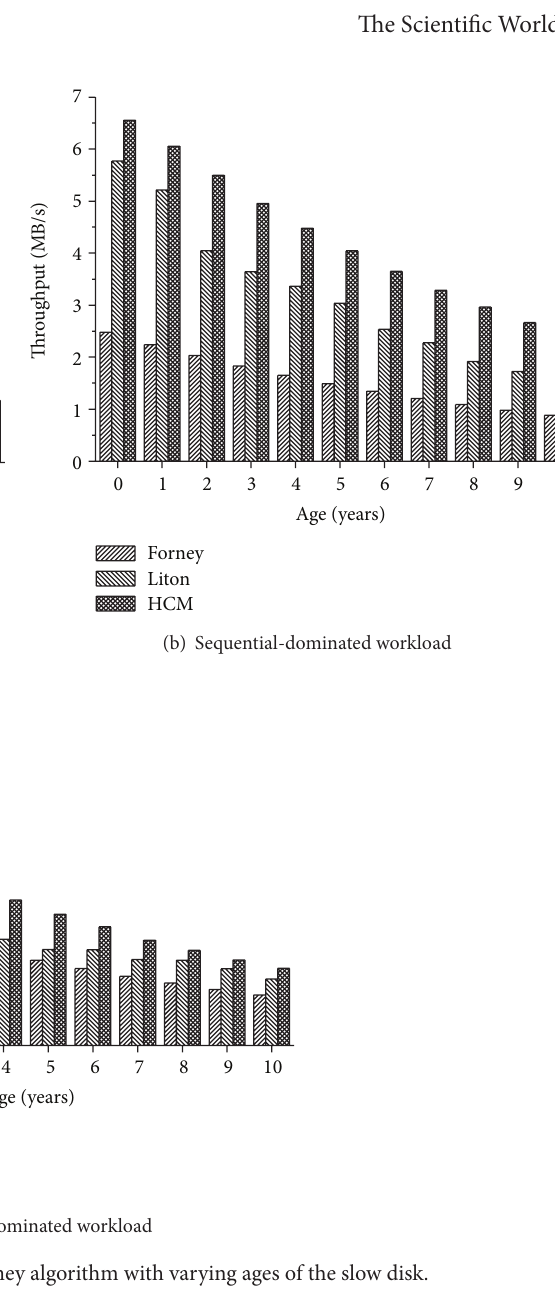
Figure 3: Throughput of the HCM and Forney algorithm with varying ages of the slow